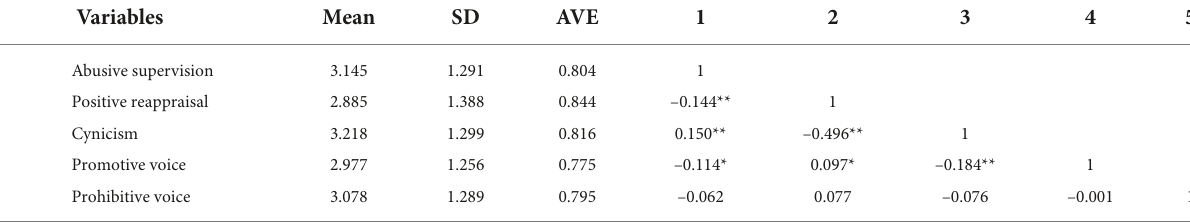
TABLE 2 Descriptive statistics, average variance extracted (AVEs), correlations and internal consistency